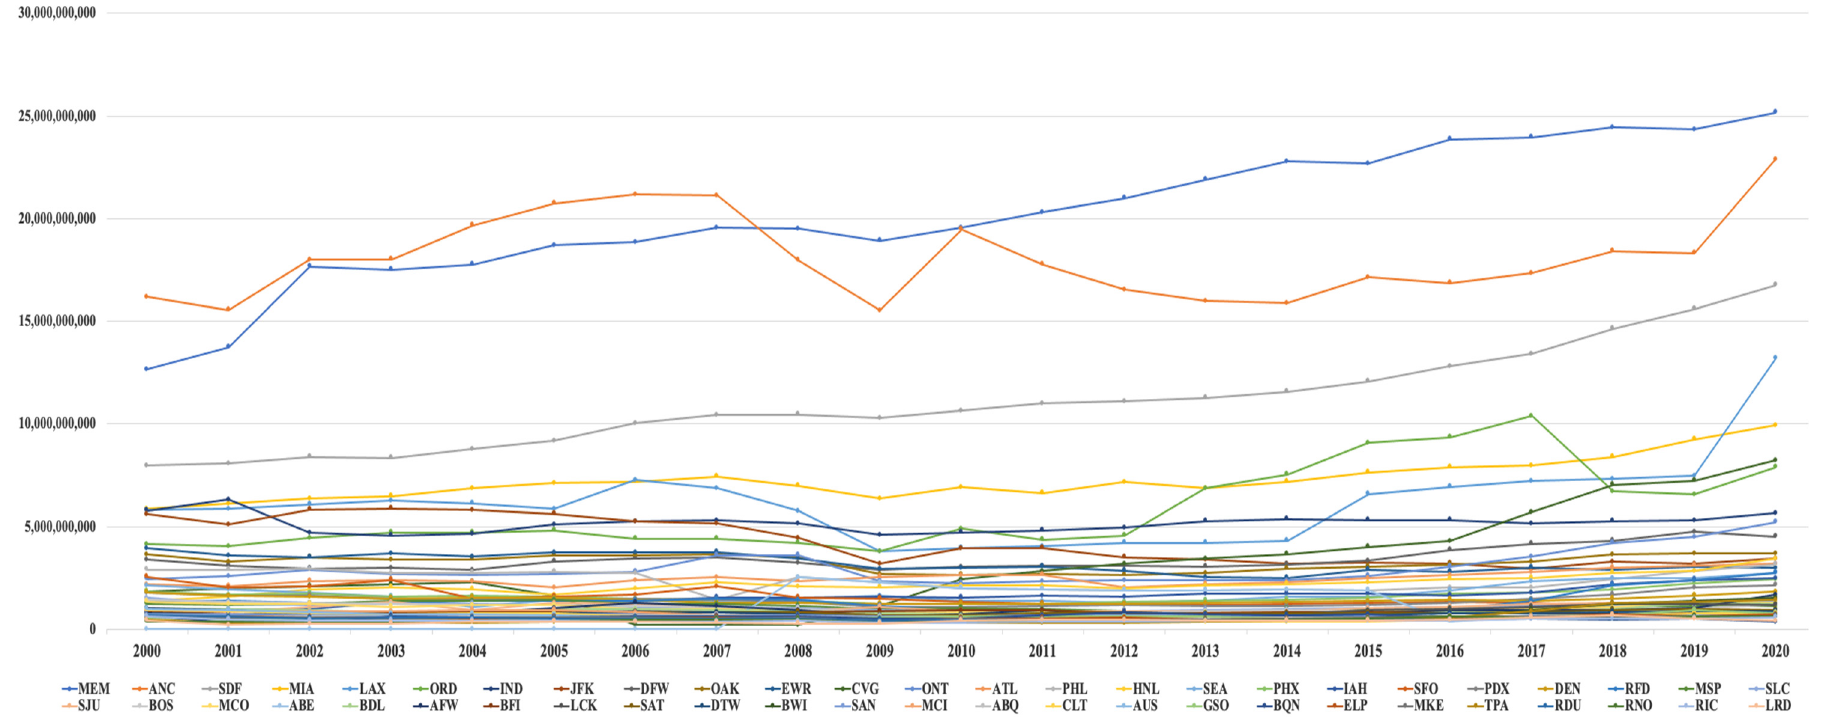
Figure 6. Freight tons carried (million) by 50 airports from 2000 to 2020. Source: Author’s own elaboration from FAA figures [108]. Lehigh Valley International (ABE) airport, data not available from 2000 to 2007.